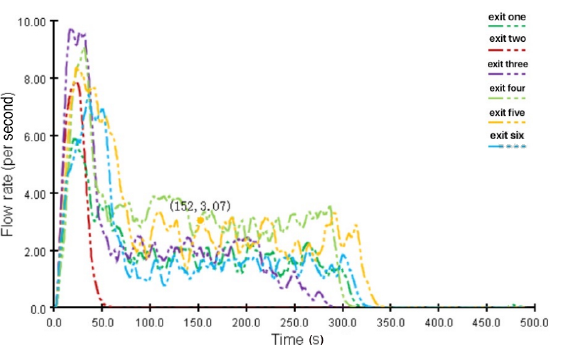
Fig. 8 Improved evacuees’ pass rate in each